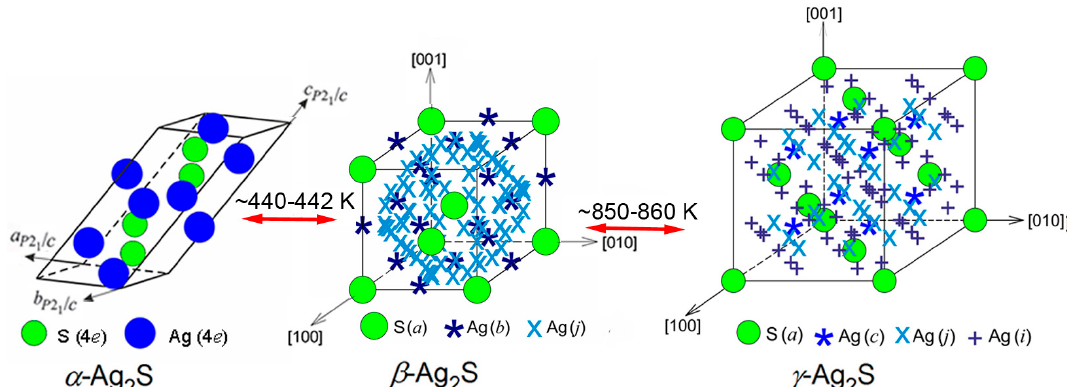
Figure 17. Change of crystal structure of silver sulfide during reversible phase transformations. The unit cells of monoclinic (space group P 2 1 / c ) α -Ag 2 S acanthite, bcc (space group Im 3 m ) β -Ag 2 S argentite, and fcc (space group Fm 3 m ) γ -Ag 2 S phase are presented. The exact positions of S atoms and sites of different types, on which Ag atoms can be located with different probabilities (see Tables 2 and 3), are shown for the β -Ag 2 S argentite and γ -Ag 2 S phase.